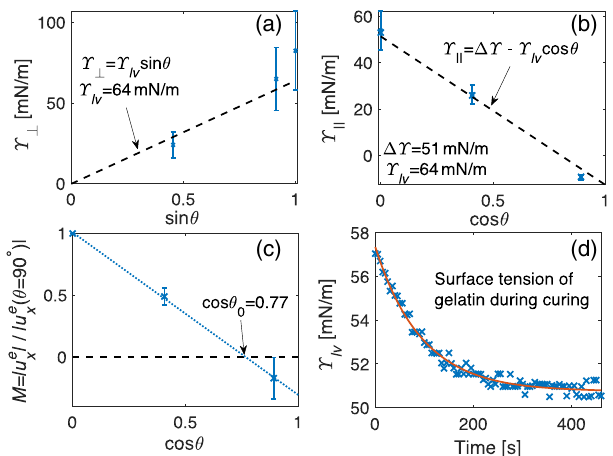
FIG. 4. Measuring surface tensions on the gel. Panels (a) and (b) show ϒ ⊥ ð θ Þ and ϒ k ð θ Þ , measured by fitting displacement fields to the theoretical expressions in Eqs. (4) and (5). The dashed line shows the theoretical predictions from Eqs. (2) and (3). Panel (c) shows M , the relative magnitudes of the displace- ment fields in Figs. 3(e) – 3(g). The angle θ 0 , where M ¼ 0 , corresponds to the point where the stresses acting at the gel ’ s surface balance horizontally. (d) The surface tension of a curing gelatin droplet, measured via pendant-droplet tensiometry. The red curve shows an exponential fit to the data, which plateaus to a value of 51